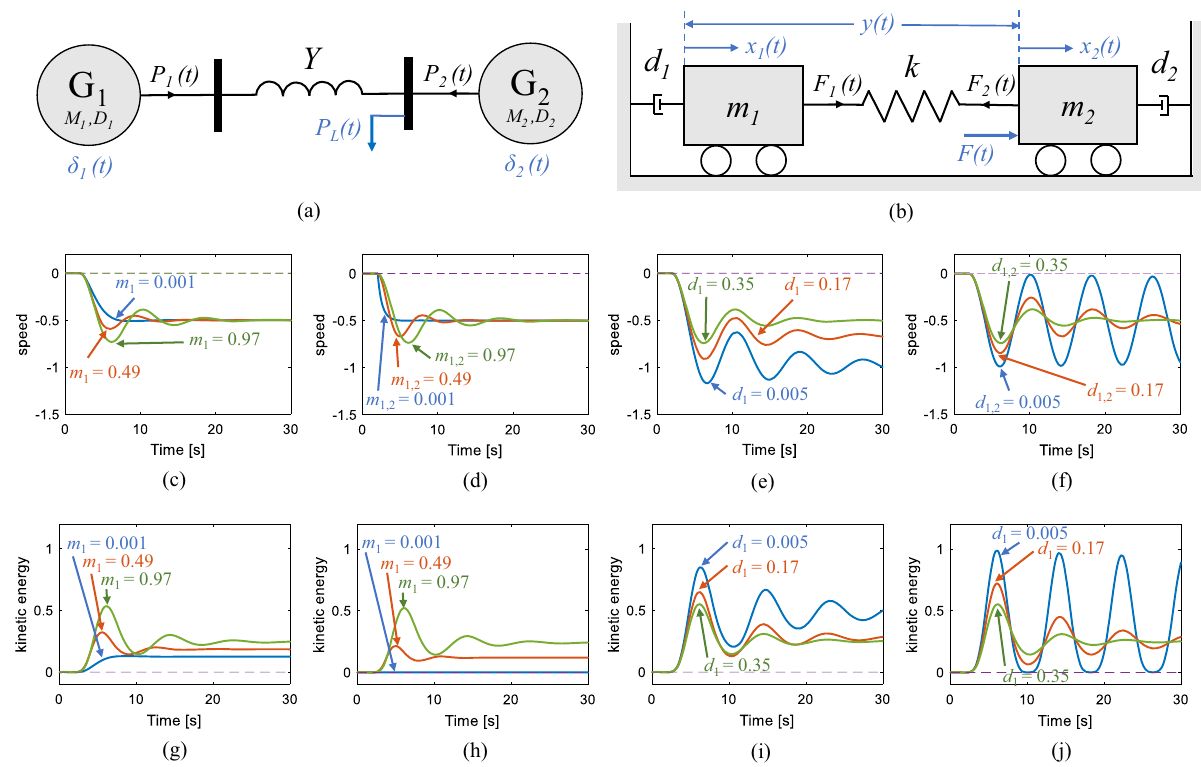
Fig. 2 Mechanical analog of synchronized operation of generators in an electric power network. a An electrical power network with two generators, G 1 and G 2 , whose inertia and damping coef fi cients are M 1 , M 2 , D 1 , and D 2 , respectively. The two generators are interconnected through a transmission line with an admittance value of Y and respond to the changes of demand of electric load P L . b A mechanical analog of the electrical power network with two bodies of mass m 1 and m 2 tied to their nearest wall with dampers d 1 and d 2 , respectively. The bodies of mass are interconnected via a spring with constant of k and respond to the external force F . Default values for constants in this network are m 1 = m 2 = 1.00, d 1 = d 2 = 0.35, and k = 0.30. The mechanical network here is subjected to an external force F and while the default values are kept unchanged, only one or two values are varied in order to conduct a parametric sensitivity analysis of the response. c , g Dynamics of speed and kinetic energy for varying values of m 1 , heterogeneous inertial mass condition. d , h Dynamics of speed and kinetic energy for varying values of m 1 and m 2 , homogeneous inertial mass condition. e , i Dynamics of speed and kinetic energy for varying values of d 1 , heterogeneous damping condition. f , j Dynamics of speed and kinetic energy for varying values of d 1 and d 2 , homogeneous damping condition. These results indicate that mechanical networks with a smaller inertial mass (all Blue traces in c , d , g , h ) and greater damping characteristics (all Green traces in e , f , i , j ) offer a more robust and stable natural synchronization capability, as the speed reaches an equilibrium faster and the kinetic energy is dissipated